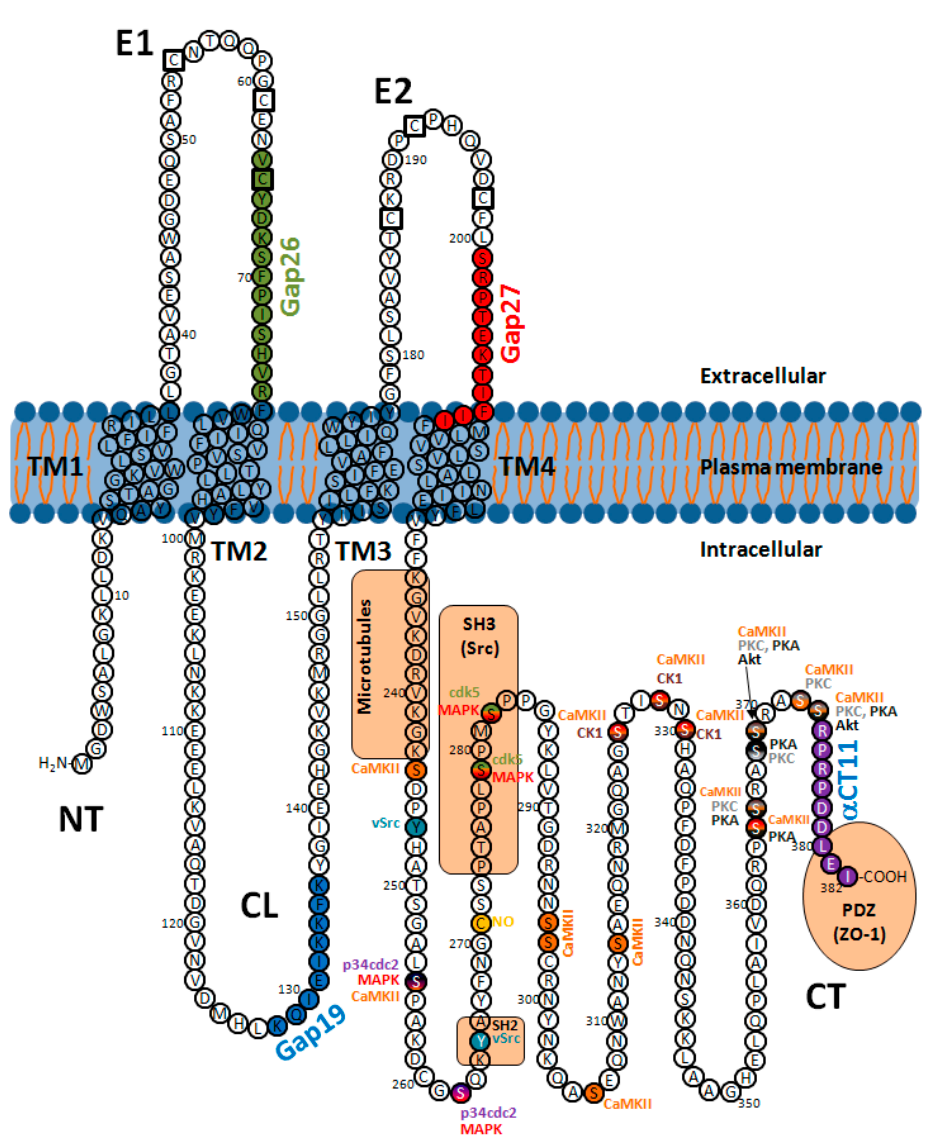
Figure 4. Human Cx43 amino acid sequence, showing location of proposed regulatory residues. Conserved cysteines in the extracellular loops (E1 and E2), important for the docking of opposing hemichannels, are shown in black squares. Interacting sequences with microtubules, zonula occludens-1 and Scr are shown inside pink boxes. Location of inhibitory mimetic peptides Gap26, Gap27 and Gap19 are shown in green, red and blue, respectively. In addition, the last 9 residues of the 25-amino acid Cx43-regulatory peptide α CT1 are shown in purple (this 9-amino acid peptide is known as α CT11). CL, NT and CT indicate cytoplasmic loop, and amino- and carboxyterminal domains, respectively. Modified from